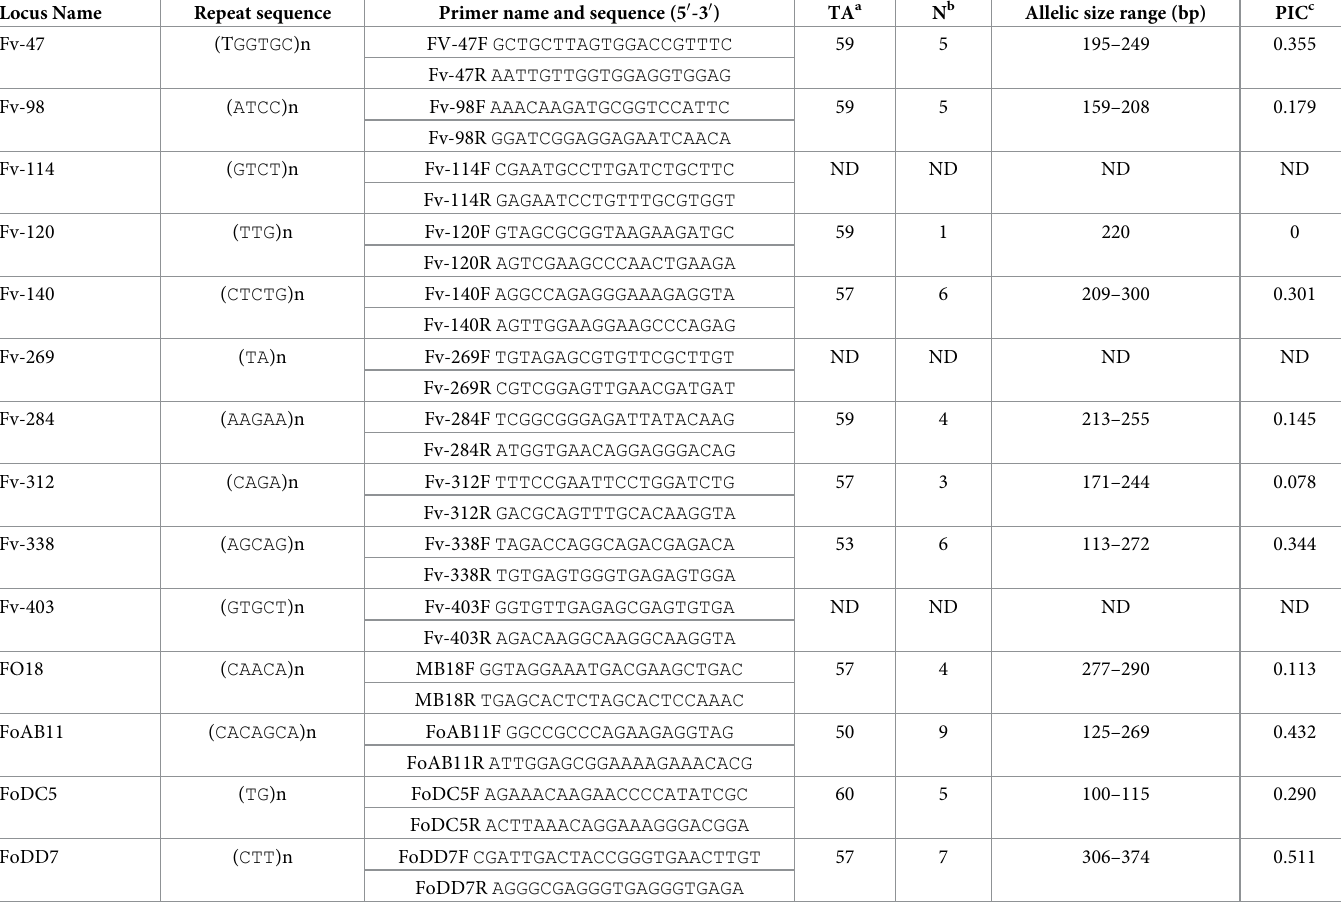
Table 1. SSR primer-pairs of F . verticillioides [8] and F . oxysporum [15, 19] used for genotyping Saudi Fusarium strains recovered from date palm trees. Locus